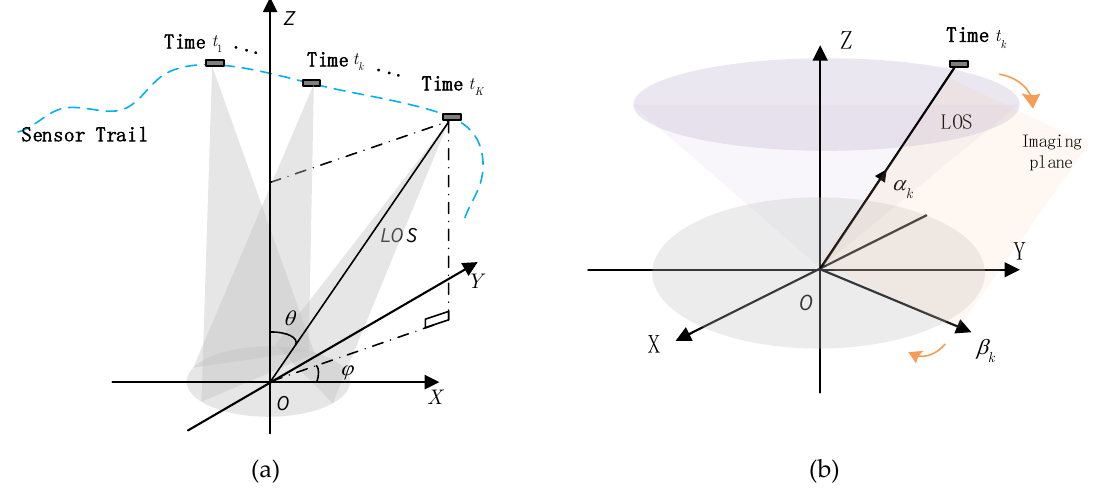
Figure 1. Radar position and the projection vectors of the k th imaging plane. ( a ) The rotation relationship between the LOS and the target. ( b ) The two-dimensional projection vectors of the k th imaging plane.